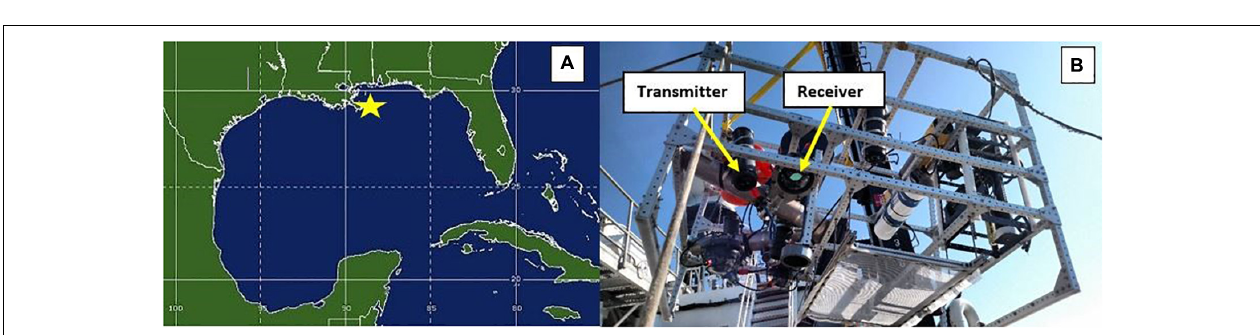
FIGURE 2 | (A) Map with yellow star showing locations of the two stations sampled. (B) Profiler set up with UMSLI transmitter and receiver configuration highlighted (yellow arrows).